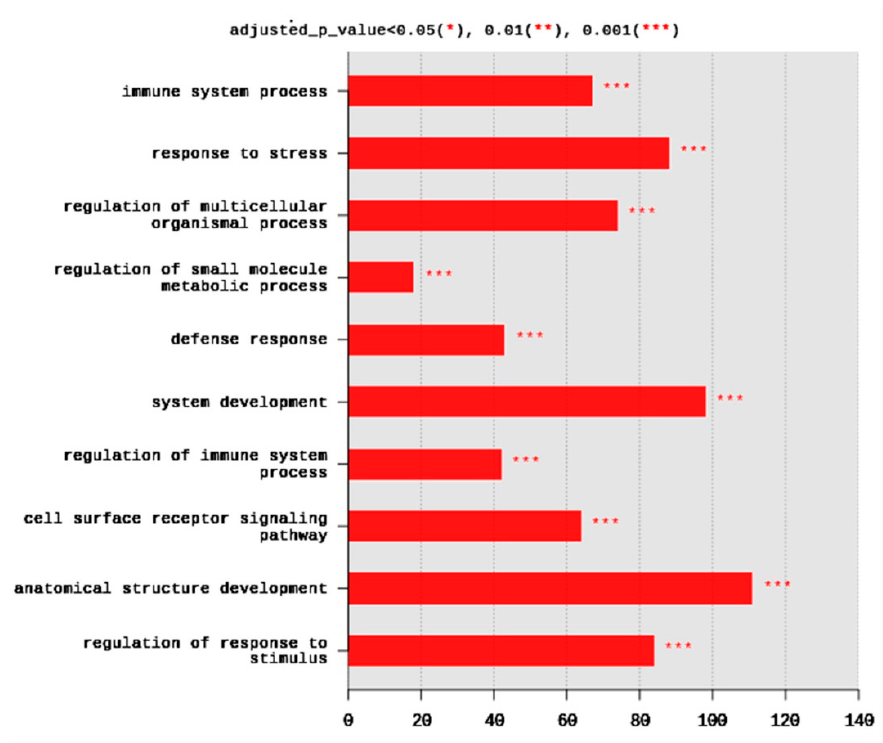
Figure 2. Distribution of the top 10 gene ontology (GO) enriched biological processes (BP) terms, adjusted p < 0.05. The Y axis represents the enriched BP terms, X axis represents the intersection size (the number of DEGs for a BP term). Int. J. Mol. Sci. 2020 , 21 , x FOR PEER REVIEW